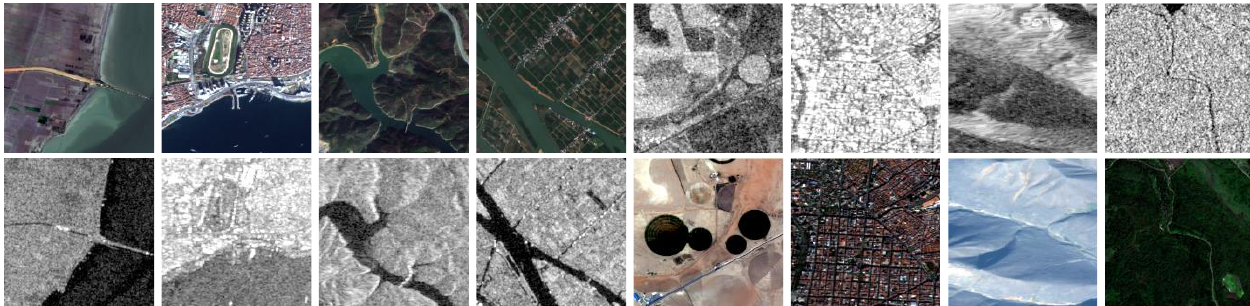
Figure 2. Some example patch pairs from the SEN1-2 dataset. Top row: Sentinel-1 SAR image patches; bottom row: Sentinel-2 RGB image patches.